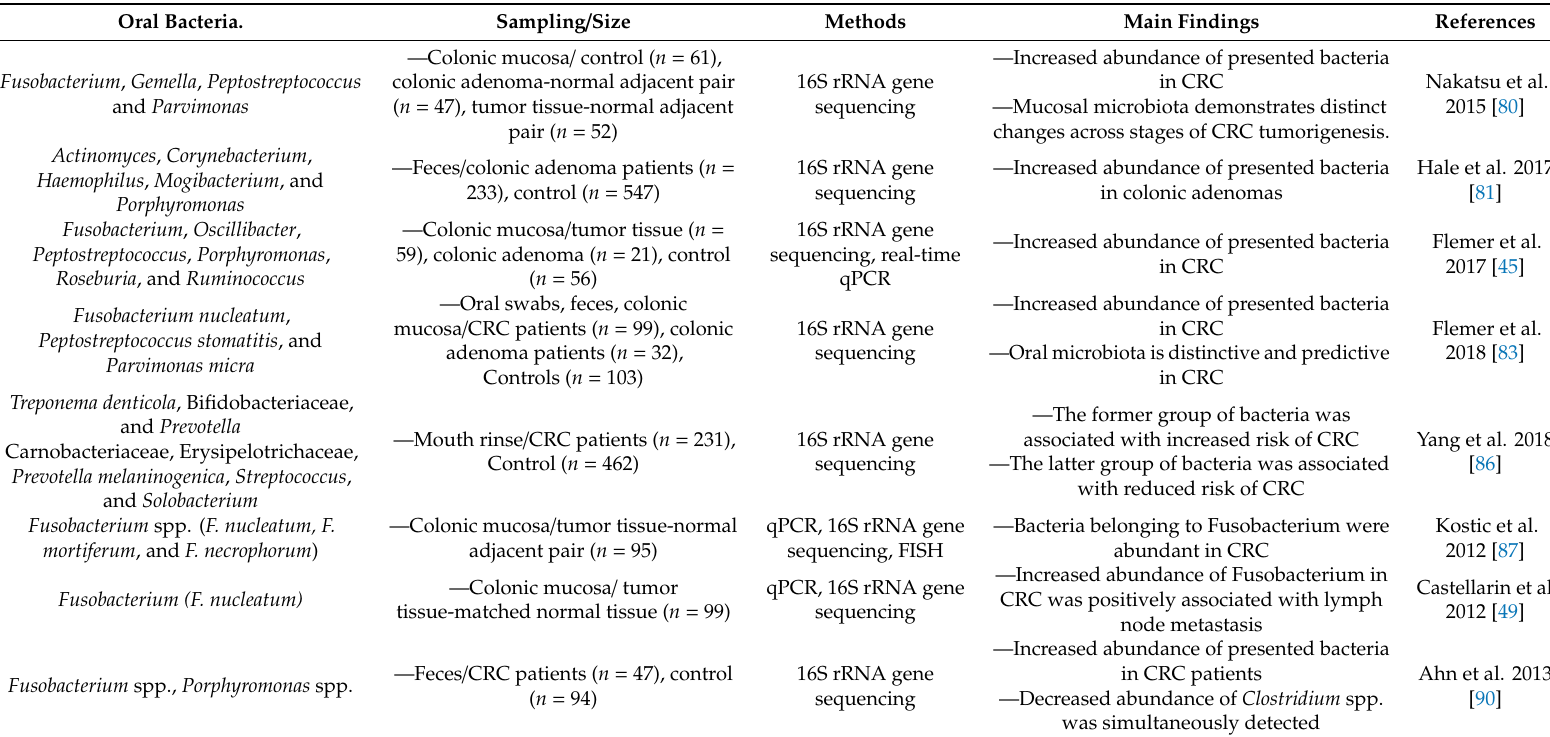
Table 1. Summary of various experimental studies regarding the presence of oral bacteria in colorectal cancer